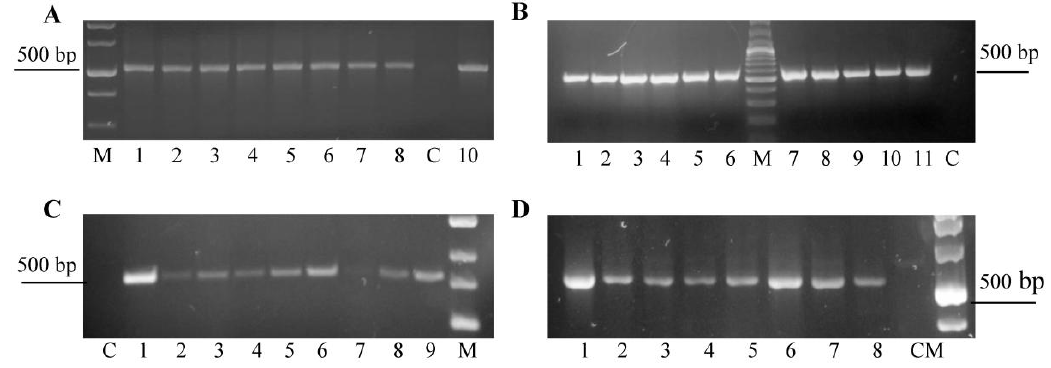
Figure 3. The results of RT PCR-analysis of transgenic chrysanthemum plants. The plants transformed with pBSS vector ( А ), pBDS ( B ), pBAS ( C ), and pRNAiVB ( D ). Numbers denote different transgenic lines. C—nontransformed control plant. М—molecular size marker. The expected lengths of the amplified fragments are 517 bp (pBSS, pBDS, and pBAS vectors) and 519 bp (pRNAiVB).